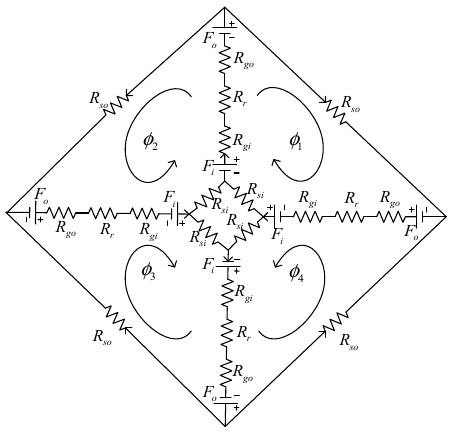
Figure 3. Equivalent magnetic circuit of Figure 2.